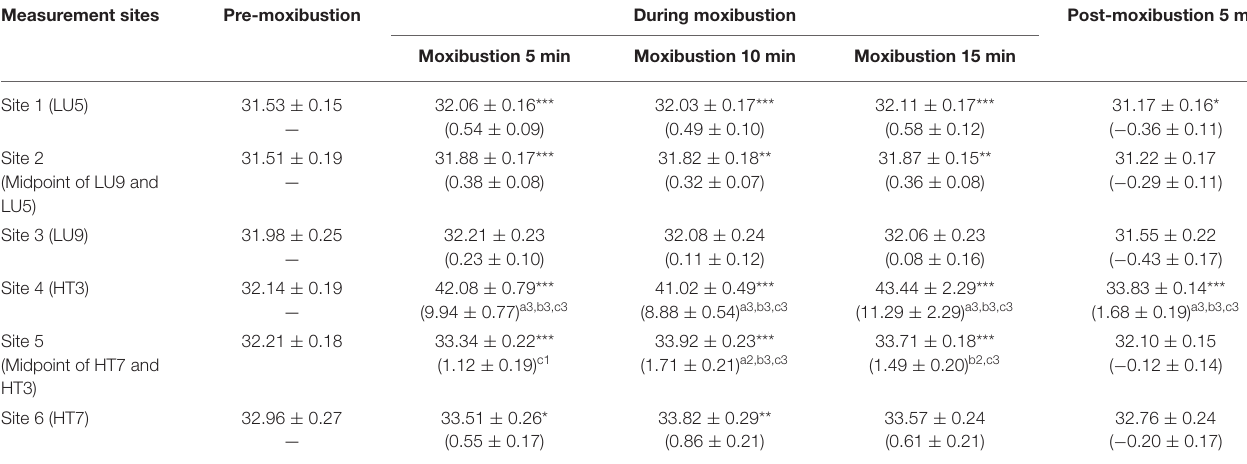
TABLE 4 | Temperature and its corresponding change magnitude in measurement Sites of both meridians in the Heart intervention group (mean ± SEM, ◦ C). Measurement